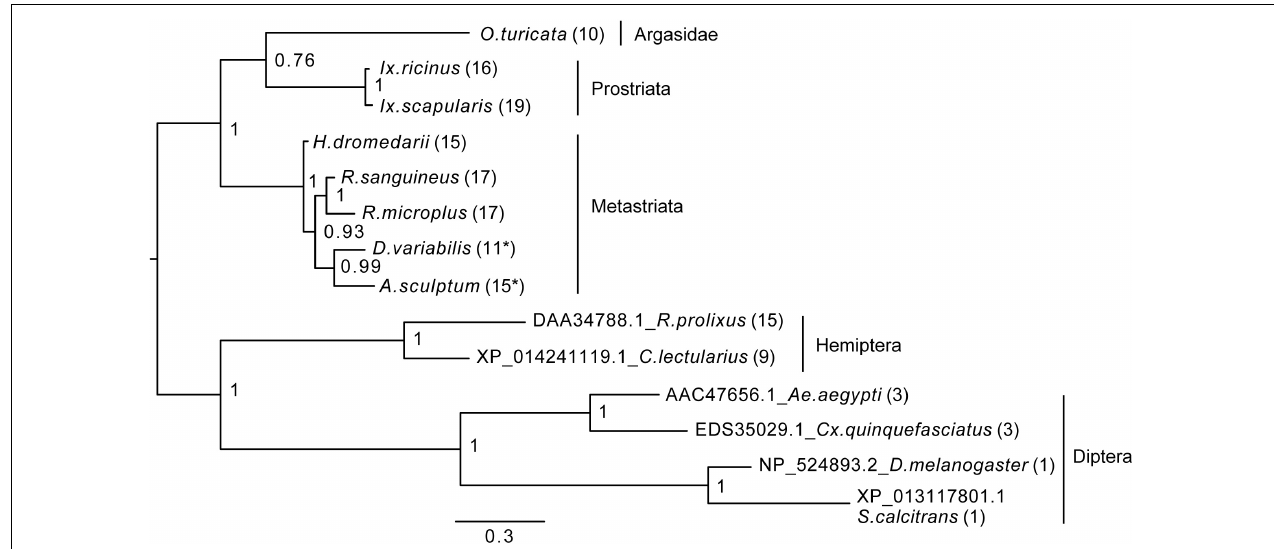
FIGURE 4 | Bayesian phylogenetic analysis of kinin precursor. The phylogenetic tree was constructed in MrBayes with four chains and four runs of the mixed amino acid model for 1,000,000 generations with a 10% burnins. Node values are Bayesian posterior probability rounded to two significant figures. Scale refers to branch length and represents the probability of an amino acid substitution along that interval. The number of kinin paracopies encoded by each precursor is denoted in the parentheses. “ ∗ ” Indicates there could be more kinin paracopies present in this species as the predicted amino acid sequence likely only encodes a fragment of the kinin precursor due to gaps present in the predicted transcripts in NCBI. The curated protein sequences and version numbers of corresponding transcript sequences are in Figure 3A